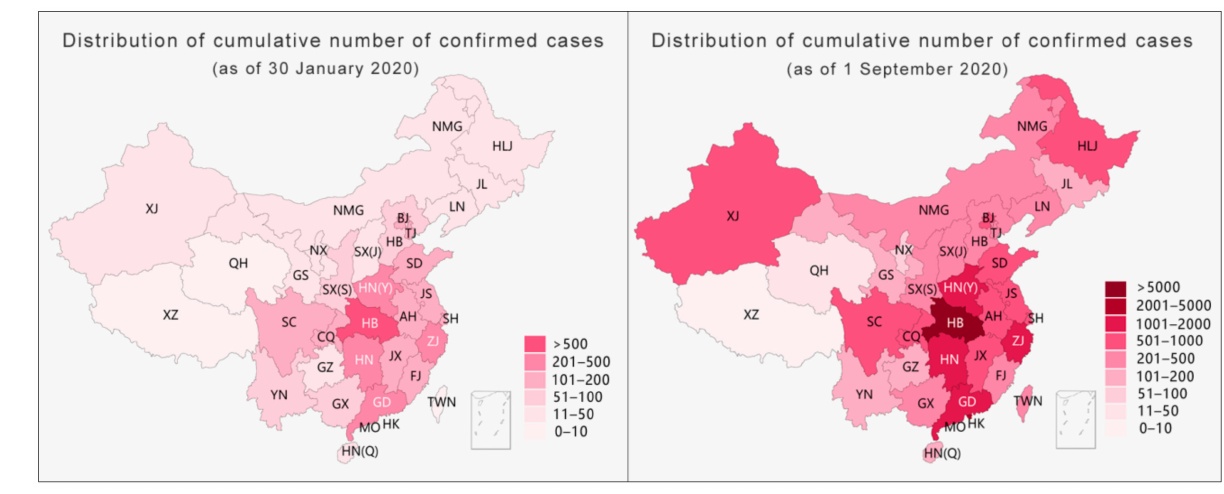
Figure 4. Method of increasing the level of classification.